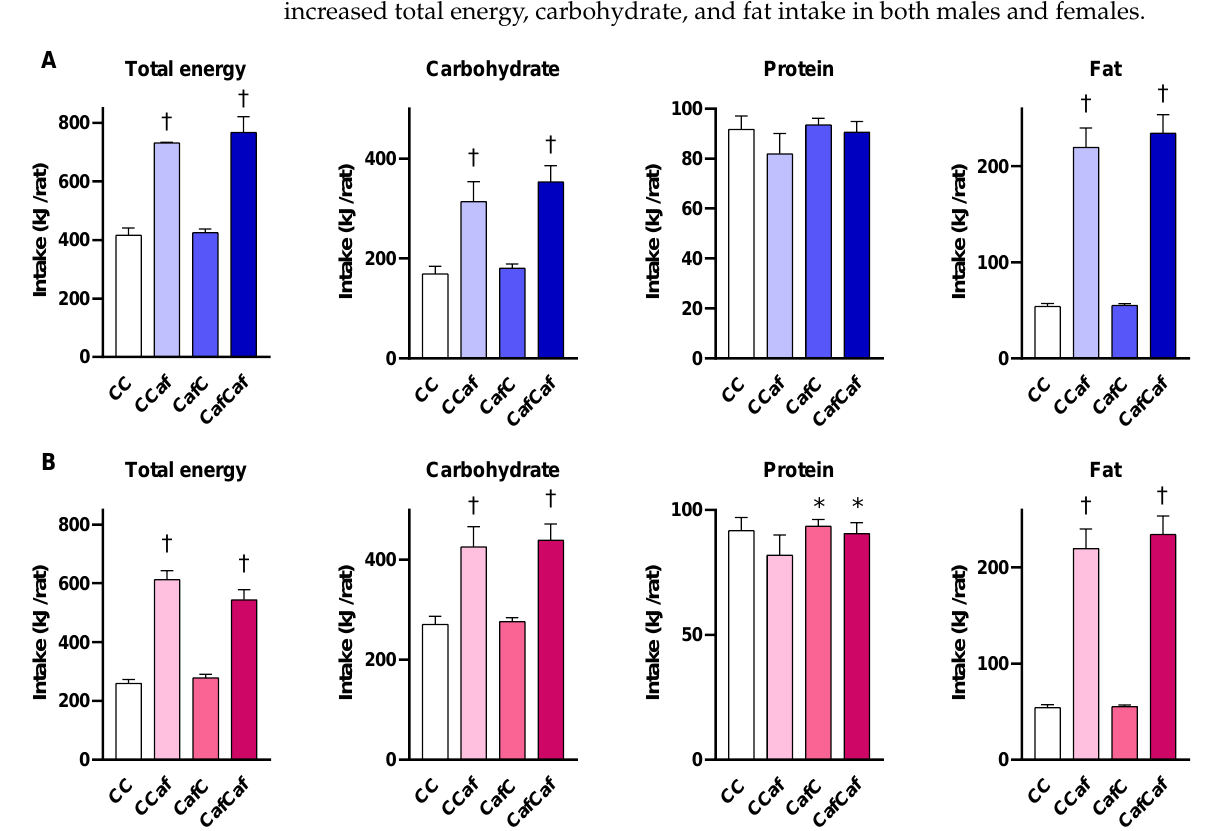
Figure 5. The 24 h food consumption and macronutrient intake of male ( A ) and female ( B ) offspring at seven weeks of age. ChowChow (11 male, 11 female), ChowCaf (11 male, 11 female), CafChow (13 male, 11 female), and CafCaf (13 male, 13 female). Data are expressed as mean ± SEM and were analysed by two-way ANOVA. * p < 0.05 significant effect of maternal Caf diet, † p < 0.05 significant effect of the offspring postweaning diet.